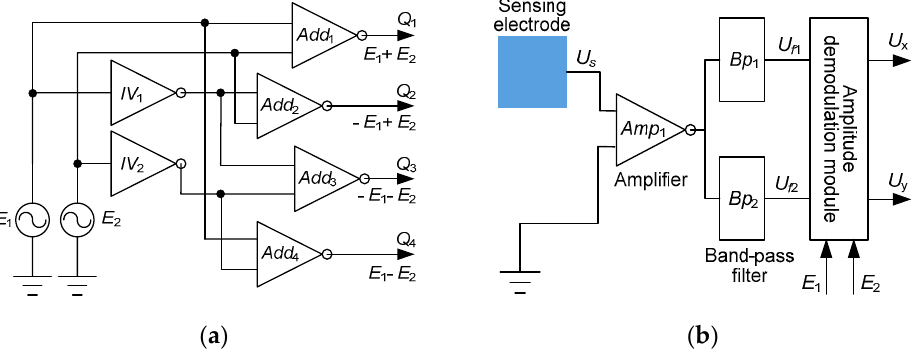
Figure 2. Electronics circuit scheme. ( a ) Driving circuit for the four quadrant electrodes; ( b ) Signal processing circuit for the mono sensing electrode.